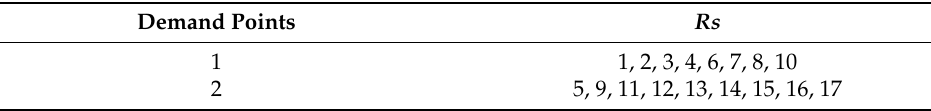
Table 3. Details on other Table 2. Demand point-project activity mapping table.